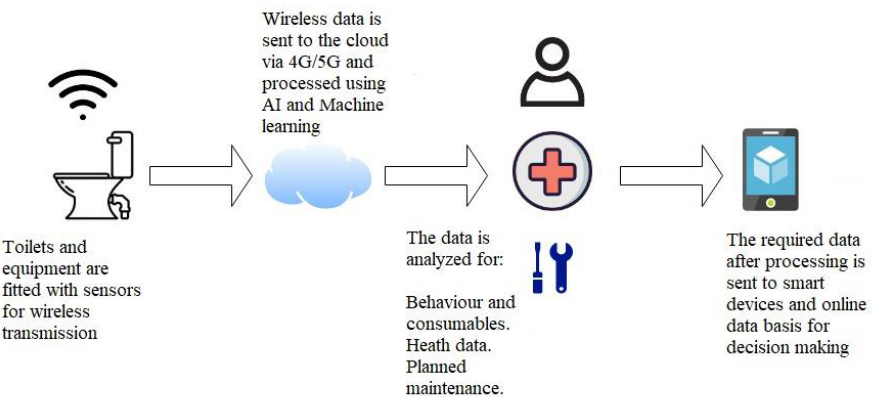
Figure 7. A prototype model of a working smart sanitation concept.